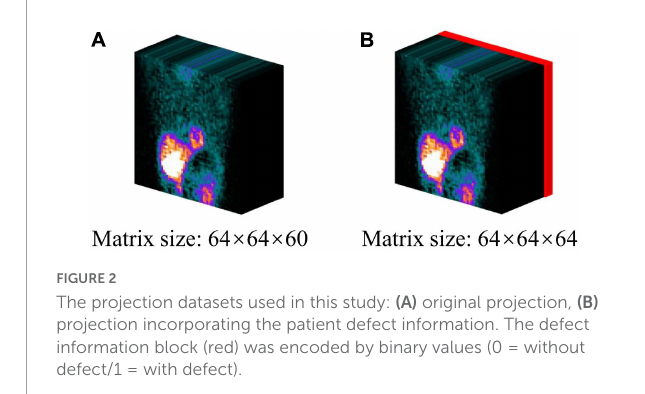
FIGURE2 The projection datasets used in this study: (A) original projection, (B) projection incorporating the patient defect information. The defect information block (red) was encoded by binary values (0 = without defect/1 = with defect).